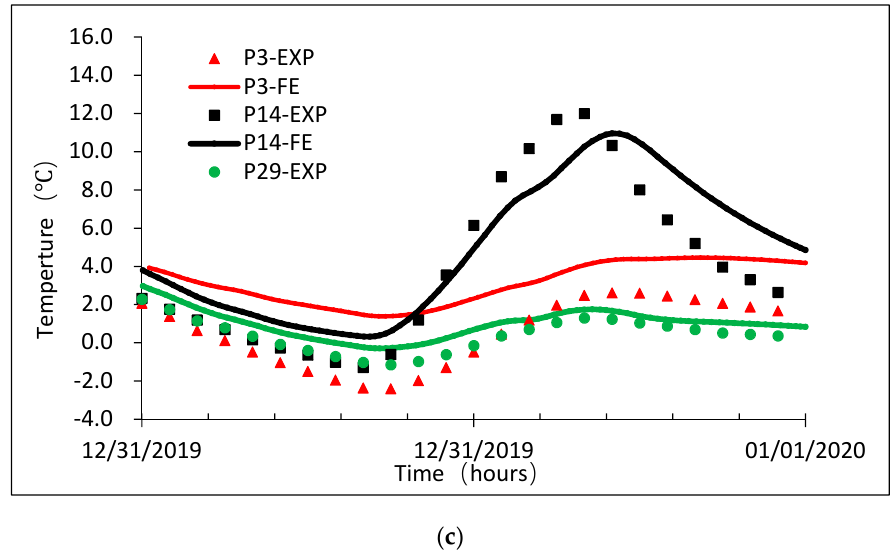
Figure 10. Measured and simulated temperature values comparisons on 31 December 2019. ( a ) Measured and simulated temperature values at the test point 1, 12, and 31 on 31 December 2019; ( b ) Measured and simulated temperature values at the test point 2, 13, and 30 on 31 December 2019; ( c ) Measured and simulated temperature values at the test point 3, 14, and 29 on 31 December 2019.